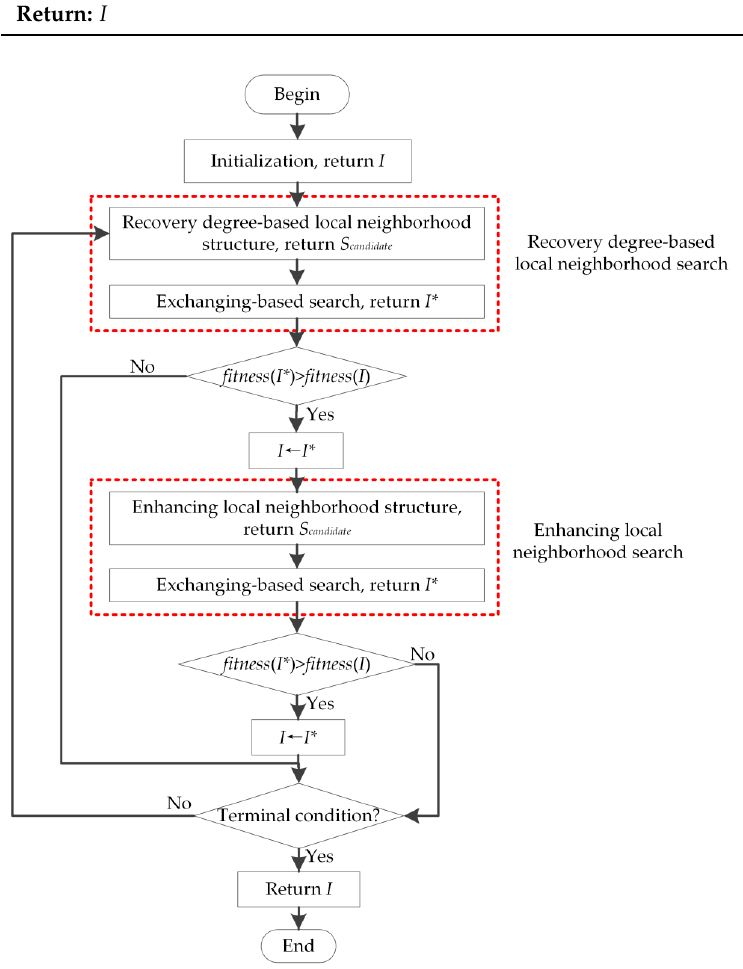
Figure 5. Flowchart of the enhanced variable neighborhood search (EVNS).